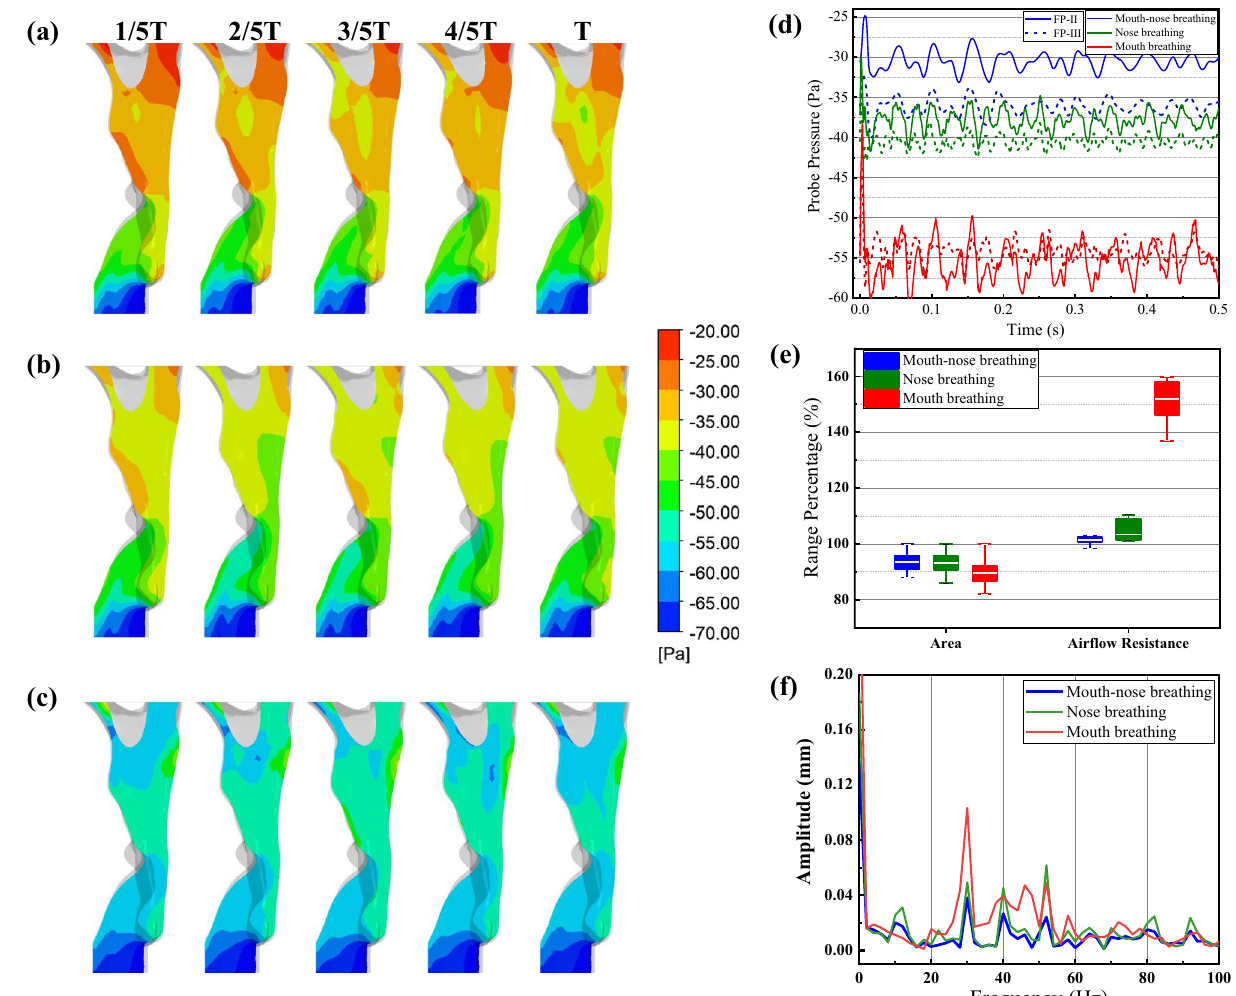
Figure 6. Comparison of aerodynamics and oropharynx vibration characteristics in three breathing patterns. ( a – c ) Pressure contours in the pharyngeal midsagittal plane within a flapping period ( ω r = 20 Hz). ( a ) Mouth- nose breathing, ( b ) Nose breathing, ( c ) Mouth breathing. ( d ) Time histories signals of two pressure probes (FP II and III) in three breathing patterns. The time-averaged pressure difference of probes (P II –P III ) were